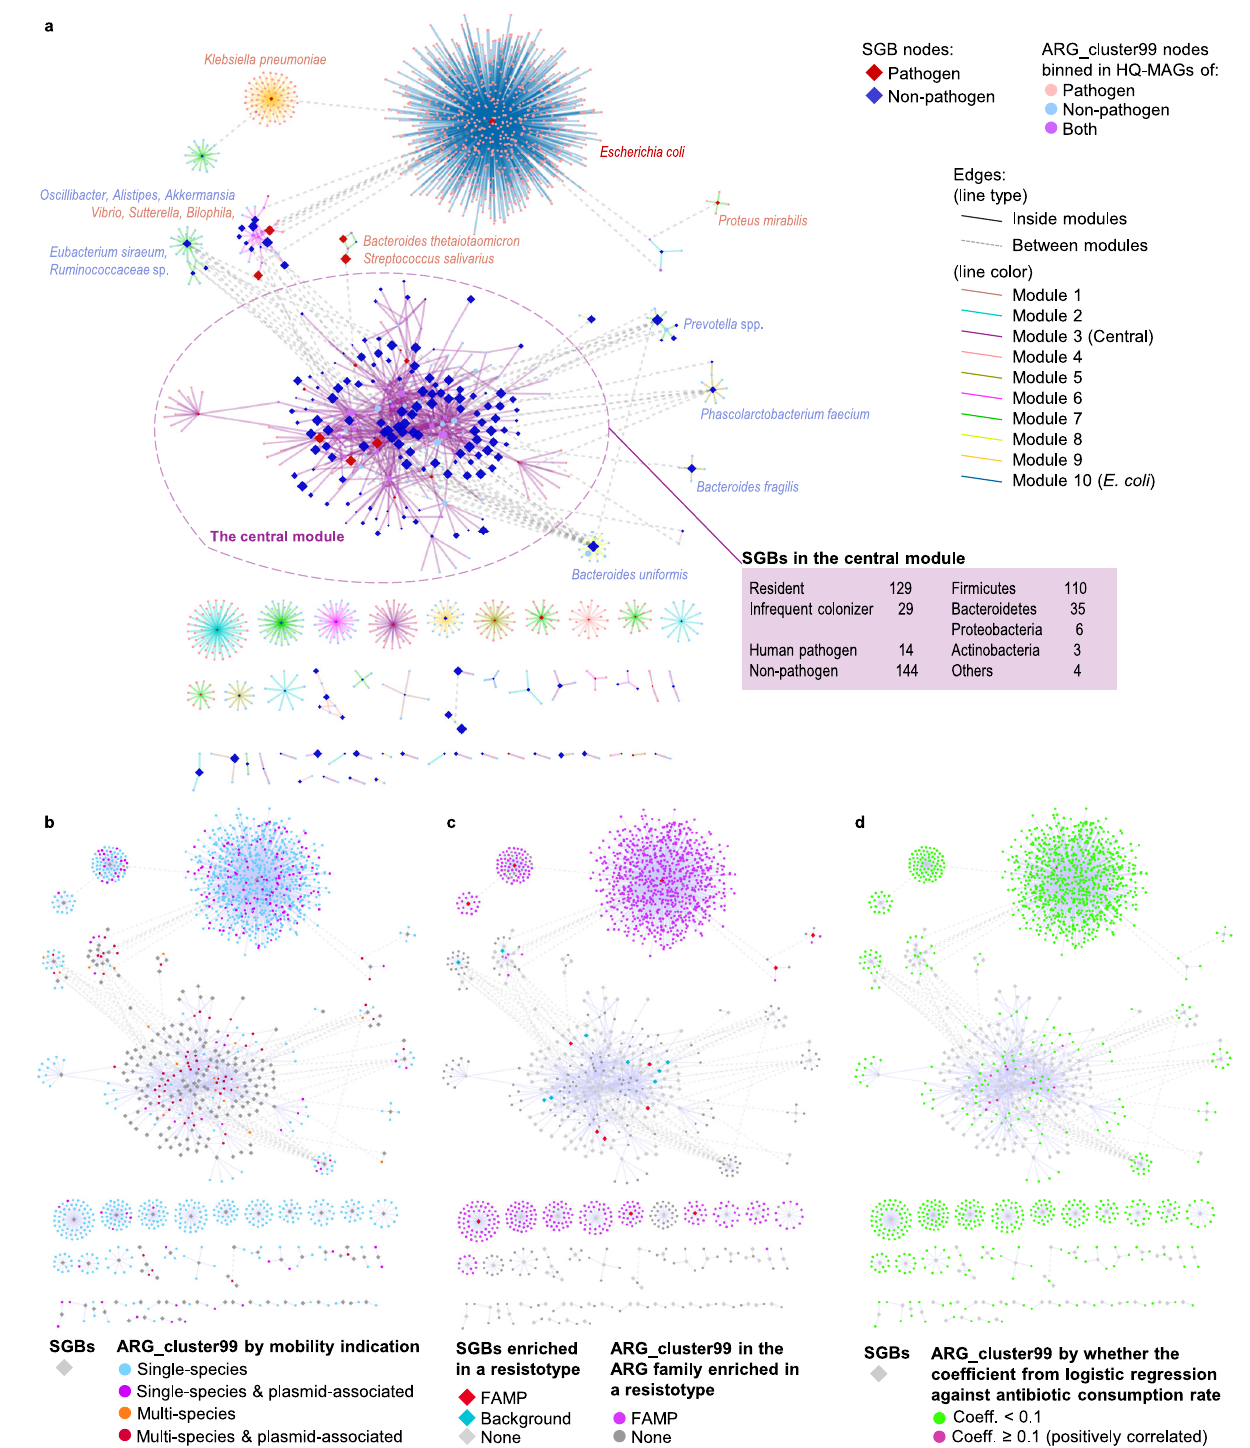
Fig.7|BipartitenetworkofARGclustersandspecies-levelgenomicbinsbased on the genomes reconstructed from stool metagenomes. Network comprising species-levelgenomicbins(SGBs)connectedtoARG_cluster99stheycontain(ORF frequency>1) generated from high-quality MAGs (HQ-MAGs) constructed from 6104 adult stool metagenomes. Ten modules in the network were detected using Beckett ’ smethod(computeModulesoftheRpackagebipartite).Thelargest(SGBs n =158) was de fi ned as `central' the others all ( n <20) as peripheral. a SGB and